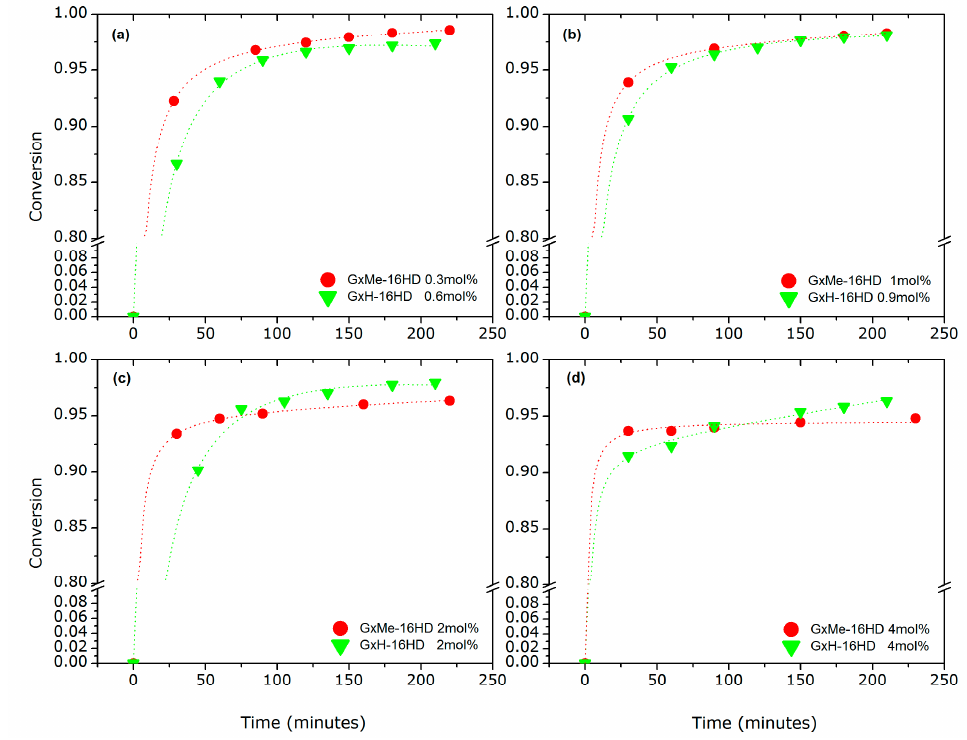
Figure 4. Conversion plots for the transesterification reactions of GxMe respectively GxH with 1,6-hexanediol when varying the DBTO concentration: 0.3–0.6 mol % ( a ); 0.9–1 mol % ( b ); 2 mol % ( c ); 4 mol % ( d ).